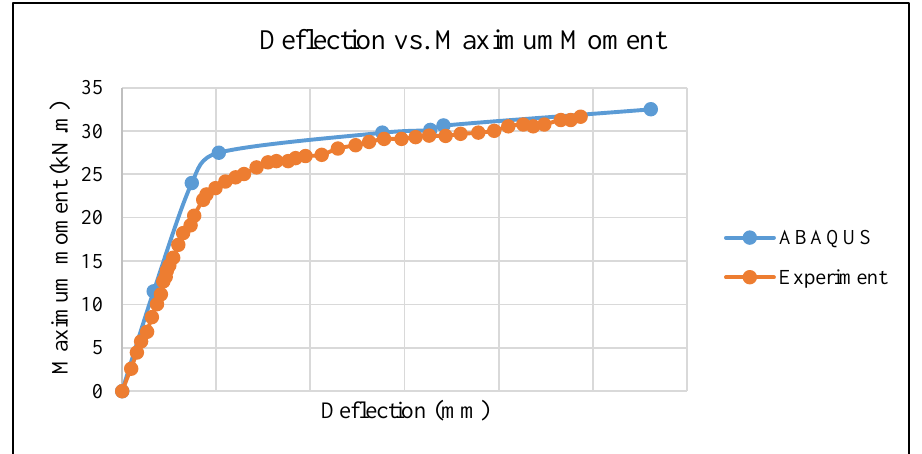
Fig. 5. Deflection vs maximum moment of specimen CFST-1.